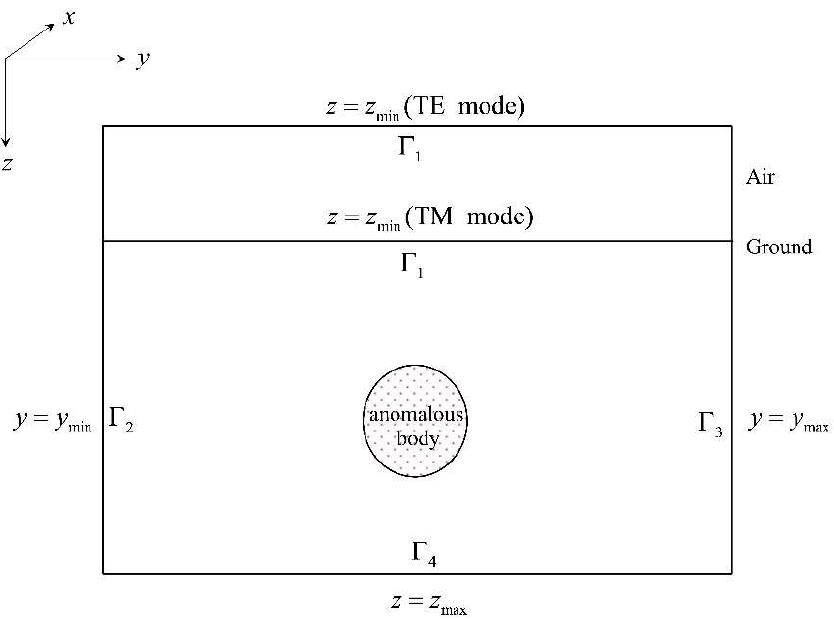
Figure 1. A sketch of computational domain for modeling 2D magnetotelluric responses.